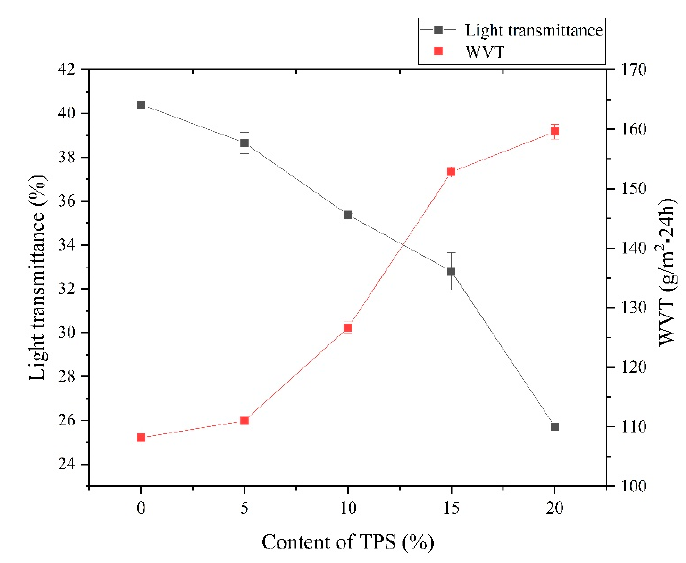
Figure 7. E ff ect of TPS content on the light transmittance and WVT of composite films. Figure 7. Effect of TPS content on the light transmittance and WVT of composite films.